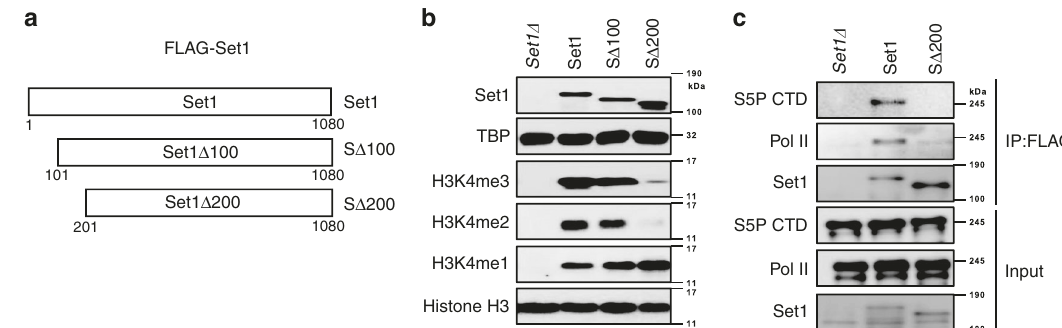
Fig. 1 The Set1 N-terminal domain is needed for RNApII interaction and proper H3K4 methylation. a Schematic of Set1 constructs used, with numbers below diagram indicating the amino acid residues from the wild-type proteins. A FLAG-tag at the N-terminus of all constructs is not shown. b Full length Set1 (Set1) and N-terminal truncated mutants (S Δ 100, S Δ 200) were transformed into set1 Δ cells. Whole cell lysates were separated by SDS-PAGE and analyzed by immunoblotting using the indicated antibodies. Lysates from cells transformed with empty vector plasmid ( set1 Δ ) served as a negative control. TATA-binding protein (TBP) and histone H3 were used as loading controls. c FLAG-tagged full-length (Set1) or Set1 Δ 200 (S Δ 200) were expressed in set1 Δ cells. Set1 proteins were immunoprecipitated with anti-FLAG beads (IP:FLAG) from whole cell lysates and analyzed by immunoblotting using antibodies for Ser5P (S5P CTD: 3E8) or total Rpb1 (POL II: 8WG16). Immunoprecipitations from cells transformed with empty vector plasmid ( set1 Δ ) served as a negative control. Bottom panels show input samples, and upper panels show proteins bound to FLAG beads after precipitation. Source data are provided as a Source data fi